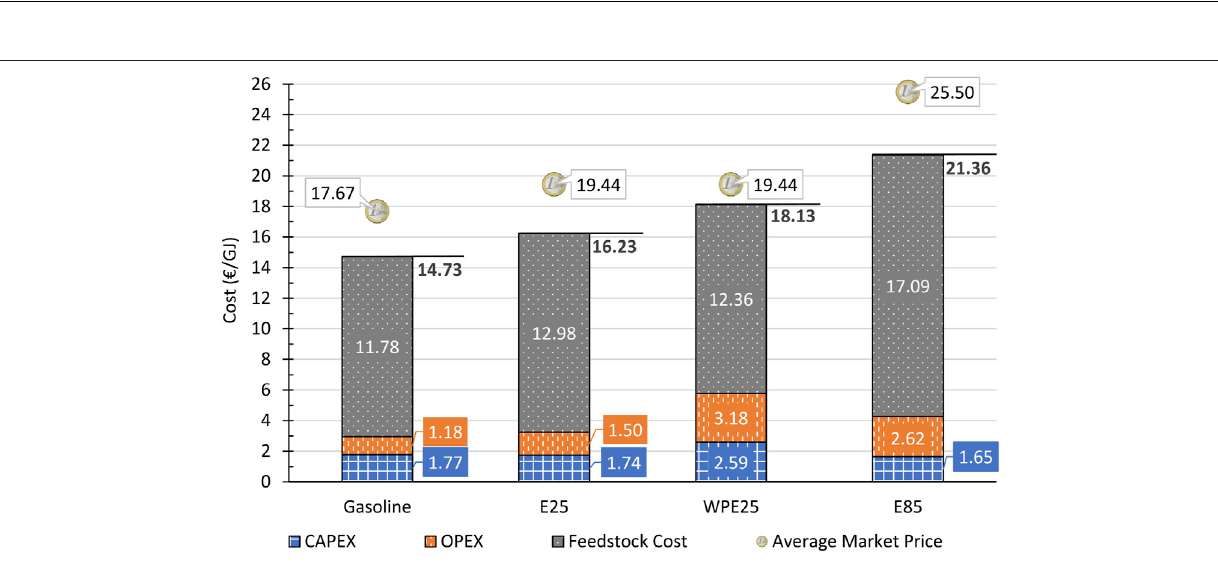
Frontiers in Energy Research |